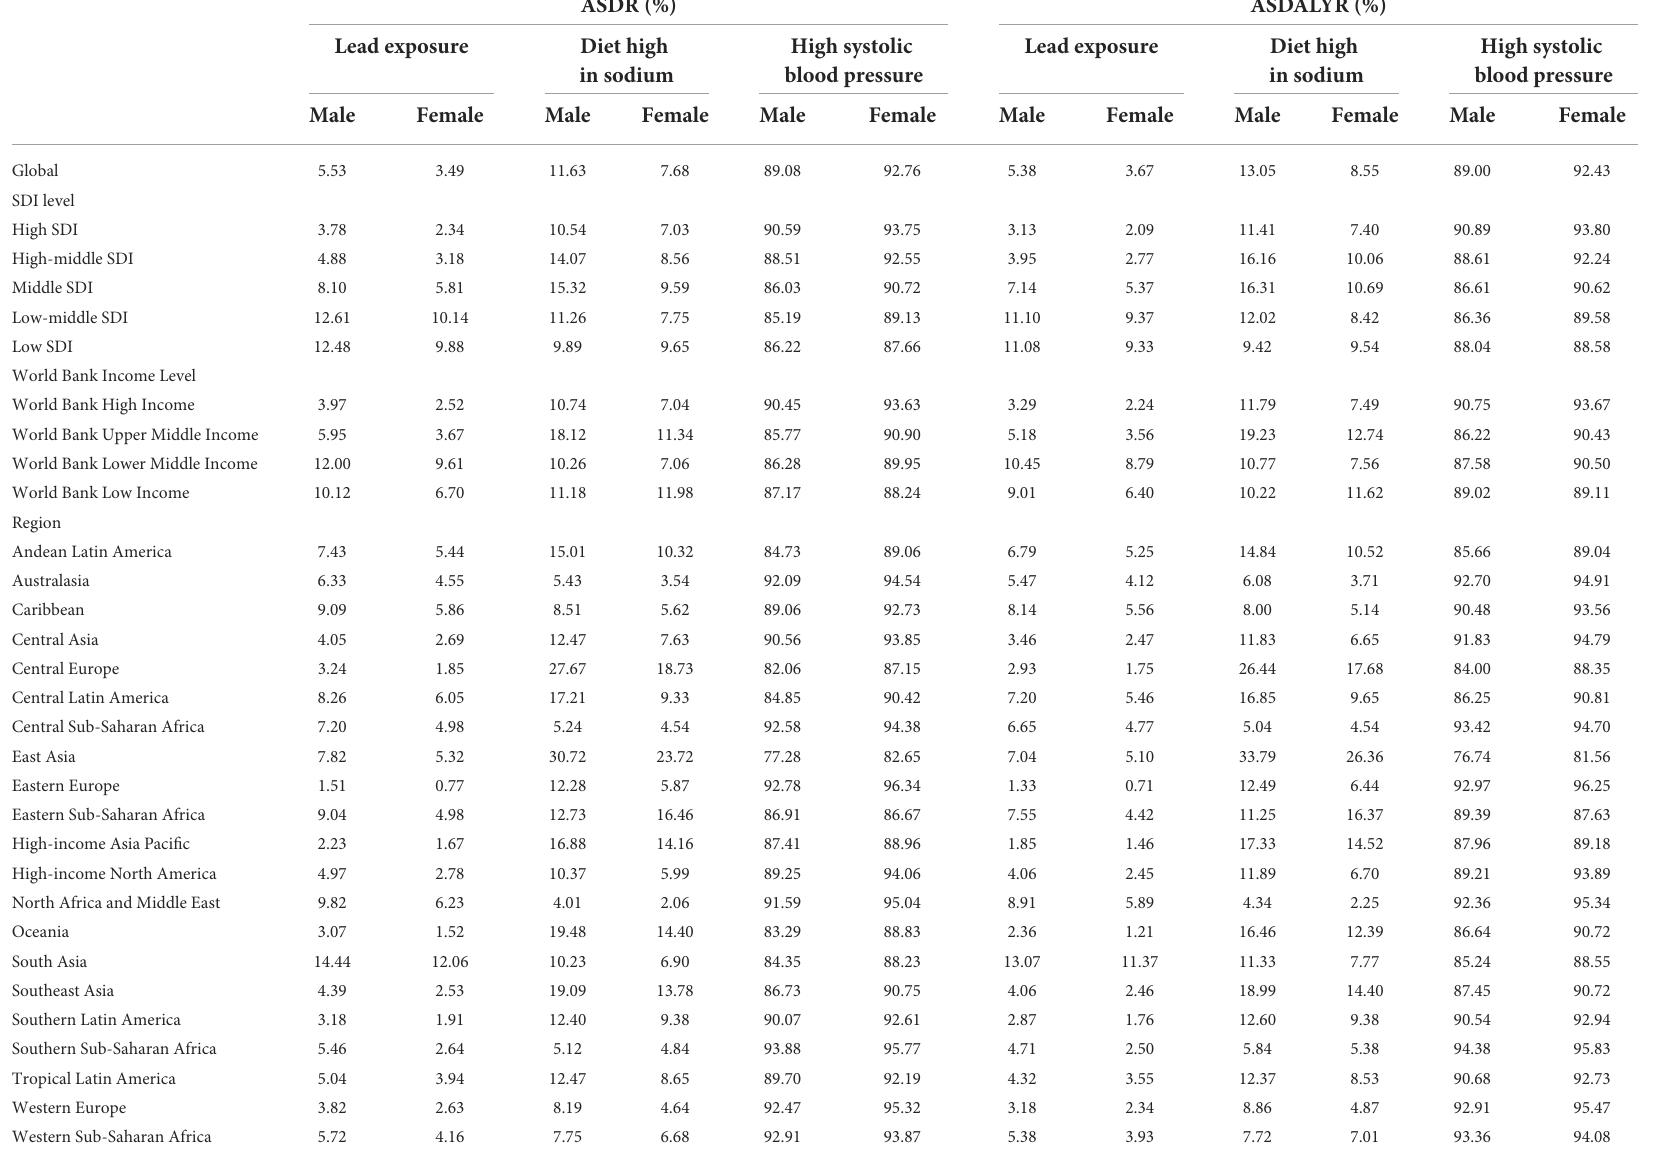
TABLE 8 PAF of attributable risks of ASDR and ASDALYR to CAVD in 2019. ASDR (%) ASDALYR (%) Lead exposure Diet high High systolic Lead exposure Diet high High systolic in sodium blood pressure in